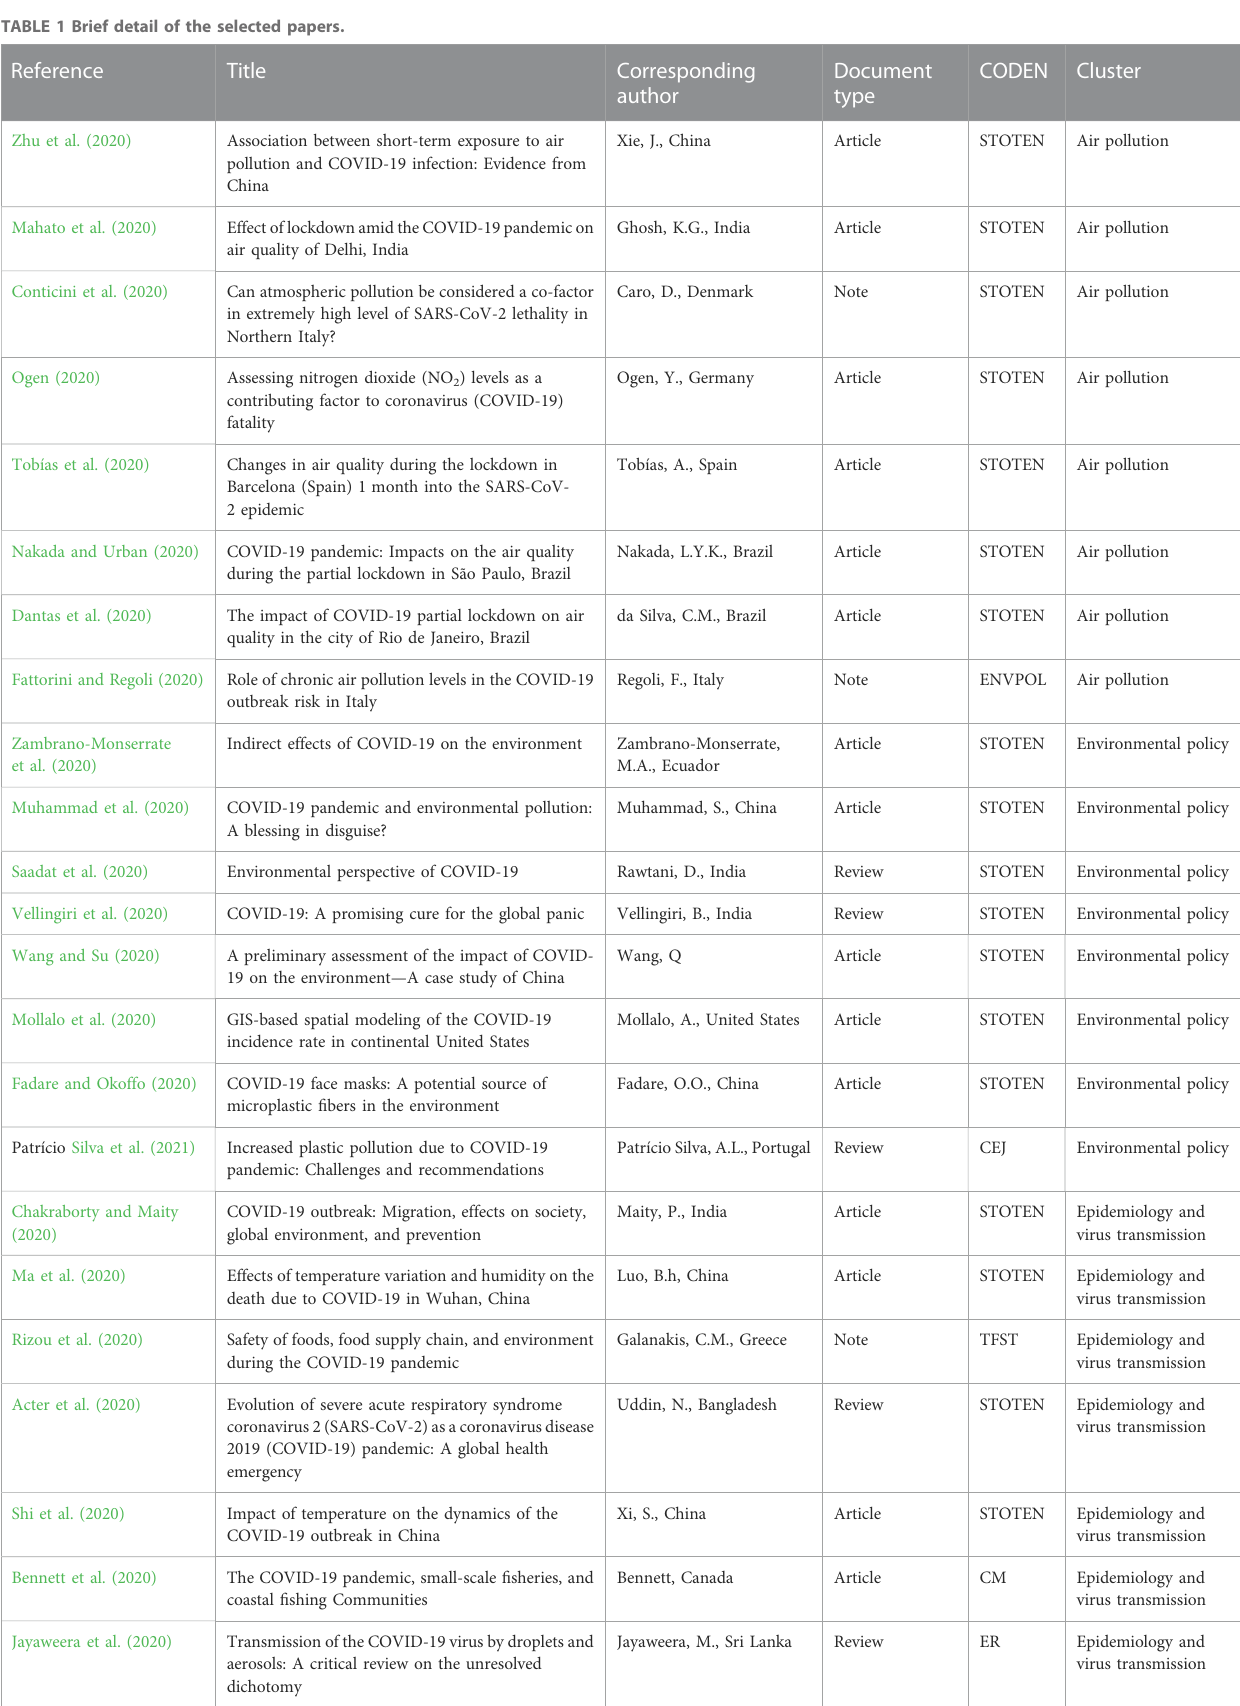
TABLE 1 Brief detail of the selected